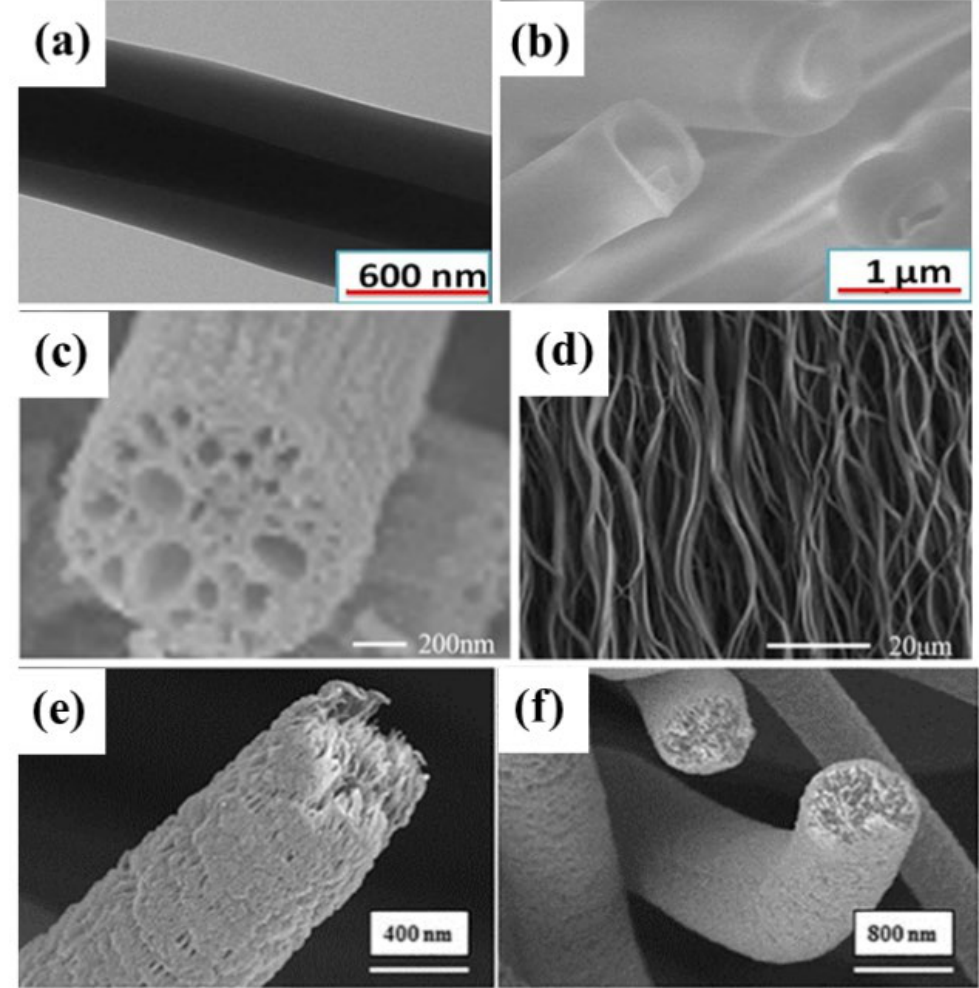
Figure 4. SEM images of NEM with different morphologies, ( a ) Core - shell structure; ( b ) Hollow structure; Reprinted with permission from ref. [44] Copyright 2017 Elsevier. ( c ) Porous structure; ( d ) Aligned structure; Reprinted with permission from ref. [34] Copyright 2020 Elsevier; ( e , f ) porous PAN micro/nanofiber membrane Reprinted with permission from ref. [43] . Copyright 2018 Elsevier.